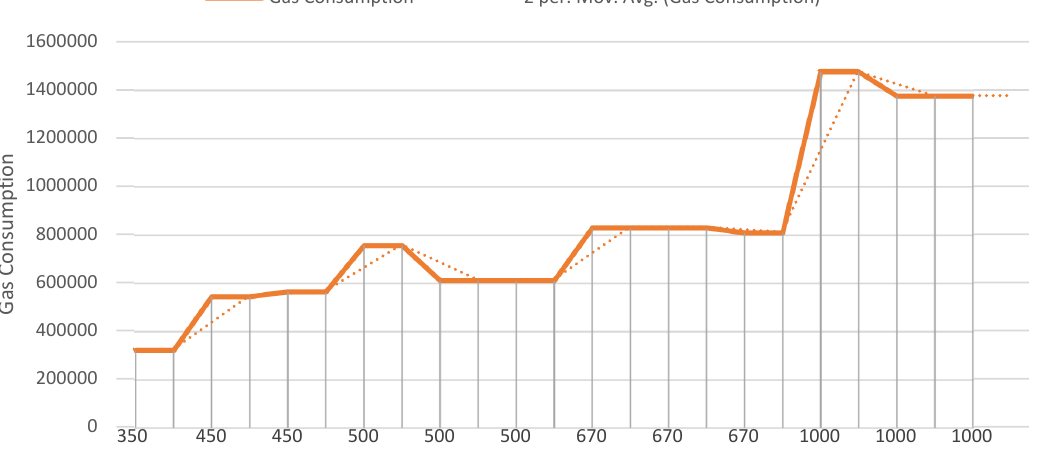
Figure 6. Gas utility based on transaction count and block size.